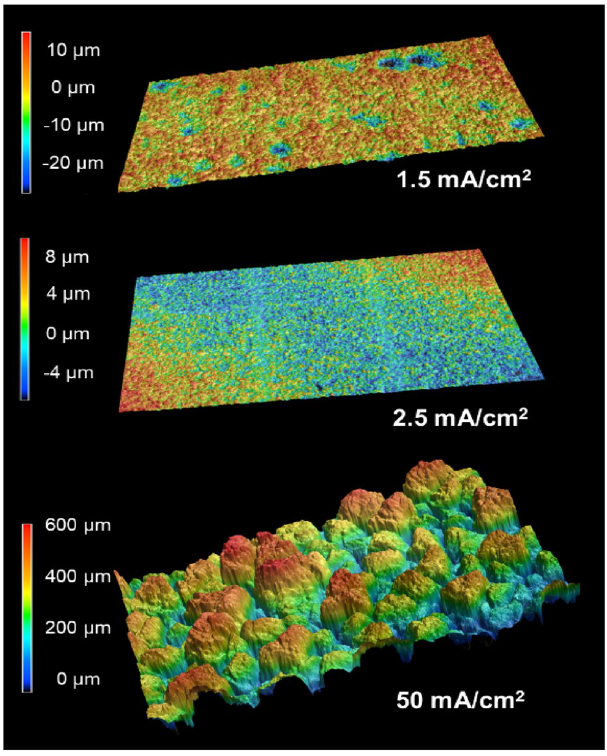
Figure 1. Optical profilometry of intact Bi films electrodeposited at 50 mA/cm 2 , 2.5 mA/cm 2 , and 1.5 mA/cm 2